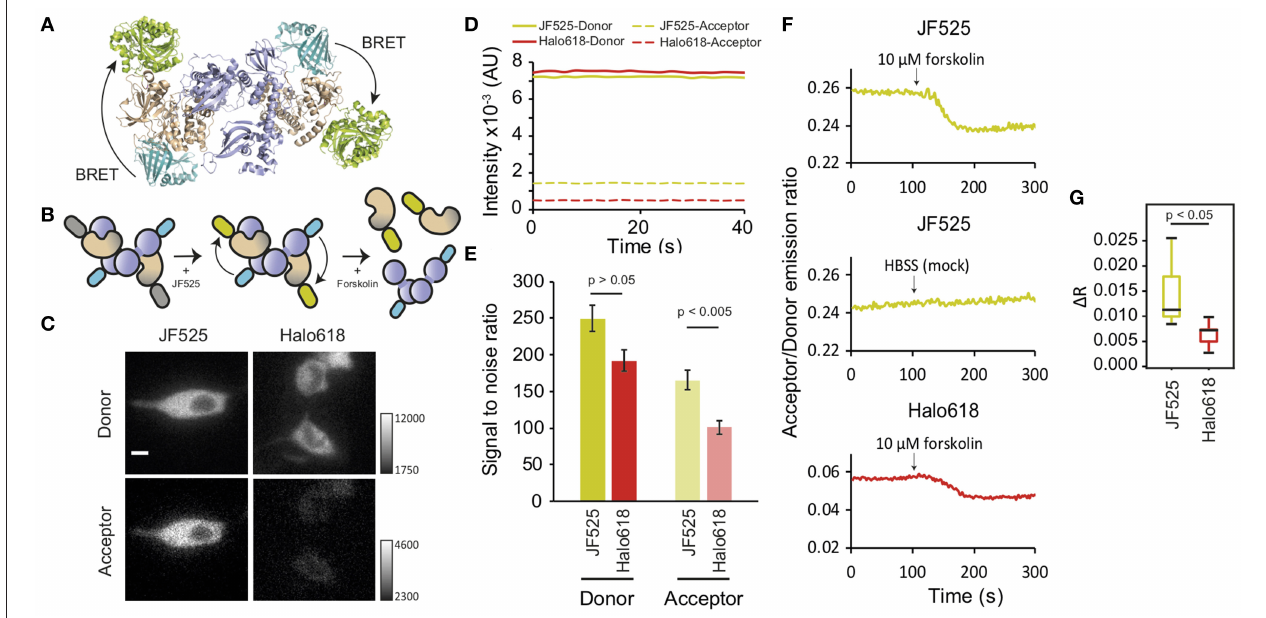
FIGURE 3 | Dissociation of PKA subunits observed by BRET. (A) Interaction of NL-RS and CS-HT modeled with the crystal structures (PDB files: 2QBVS, 2F7E, 5IBO, 5Y2Y). The regulatory subunit is shown in purple, catalytic subunit in wheat, NanoLuc in cyan, and HaloTag in greenish-yellow. (B) Schematic explaining the decrease in BRET upon dissociation of PKA subunits. The tetrameric structure of tagged NL-RS and CS-HT under resting condition (left) is labeled with HaloTag ligands (middle) and stimulated with forskolin to dissociate the interaction of RS and CS (right). (C) Luminescence images of NIH3T3 cells co-expressing NL-RS and CS-HT. Images were acquired after loading respective HaloTag ligands (JF525 and Halo618). All images were acquired with identical camera settings. Scale bar = 10 µ m. (D) Representative intensity traces of donor and acceptor signals and (E) Mean SNR ± SEM for cells labeled with either JF525 or Halo618. (F) Time traces of acceptor/donor emission ratios showing dissociation of PKA subunits NL-RS and CS-HT upon forskolin stimulation (indicated by black arrow). (G) Box plot showing 1 R A / D values for cells labeled with respective HaloTag ligands. n =